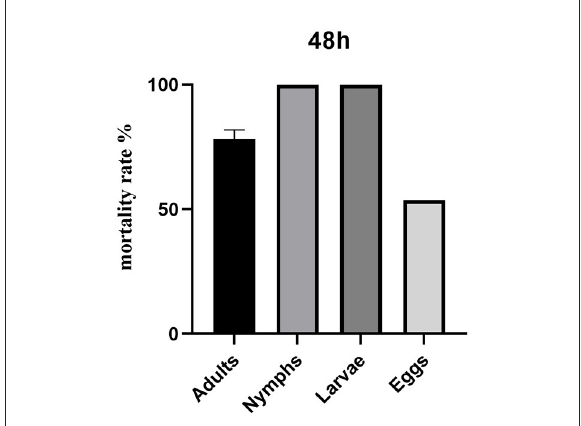
FIGURE2 Contact toxicity after 48h of treatment with star anise LC 90 + motherwort LC 90 against different development stages of Dermanyssus gallinae .